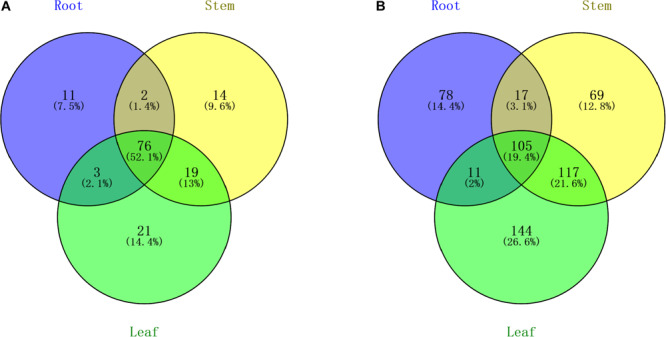
Venn diagram indicating the common and unique microRNAs in the root, stem, and leaf small RNA libraries. (A) Known miRNA distribution and (B) novel miRNA distribution.